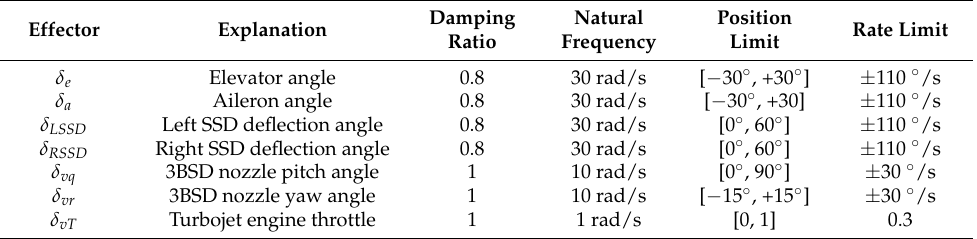
Table 3. Effector characteristics of the